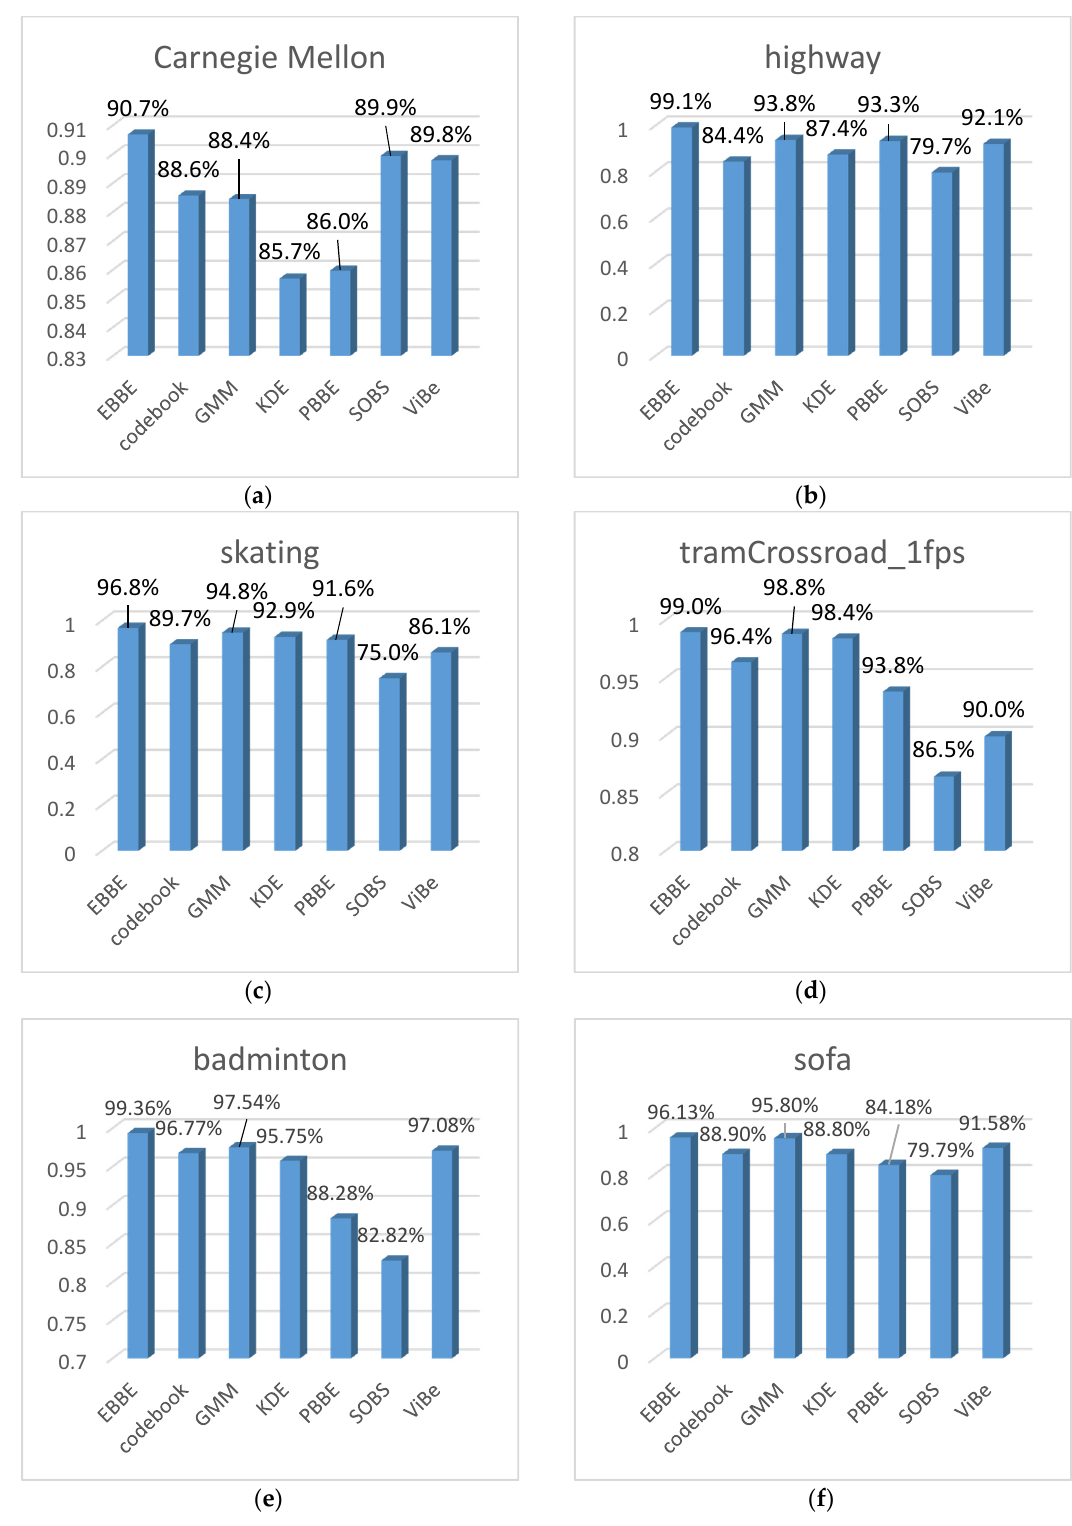
Figure 13. PCCs of seven background subtraction methods. ( a ) Results for the sequence (Carnegie Mellon). ( b ) Results for the sequence (highway). ( c ) Results for the sequence (skating). ( d ) Results for the sequence (tramCrossroad_1fps). ( e ) Results for the sequence (badminton). ( f ) Results for the sequence (sofa). Table 4. Overall results across all test sequences.